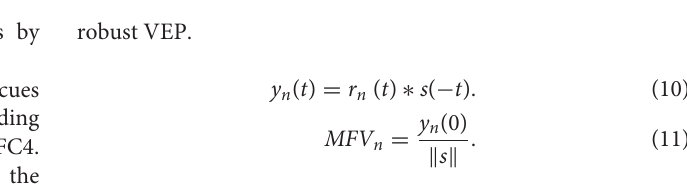
( Figure 2 ). Such a procedure removes peri-stimulus bias by phase of the evoked potential in all subjects ( Figure 3